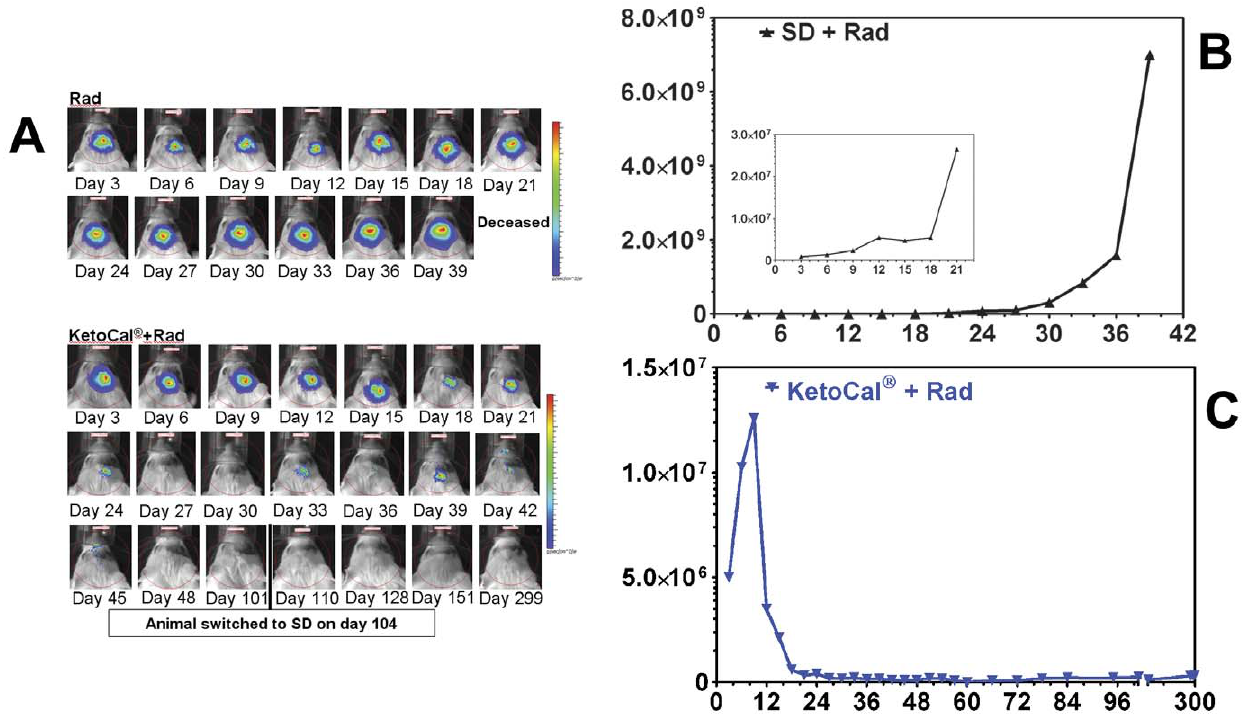
Figure 2. KetoCal H plus radiation treated animals experienced a loss of bioluminescence. (A) Radiation and KetoCal H plus radiation animal imaged every three days. Color scheme represents signal intensity with red representing the highest intensity photon count. (B) (C) Bioluminescent signal plotted as in vivo photon count versus days post-implantation.